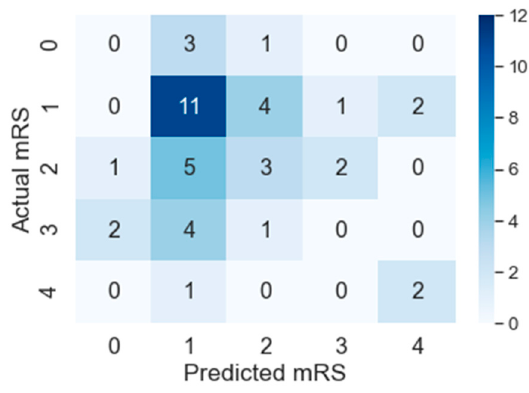
Figure 12. Confusion matrix of PMFE-SN with augmentation.